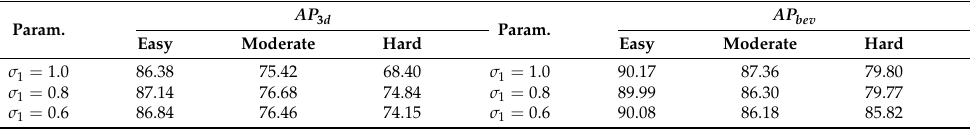
Table 7. Results for the number of positive samples. σ 1 controls the number of positive samples during training. We set σ 2 = 0.45 in this experiment. AP 3 d Param.